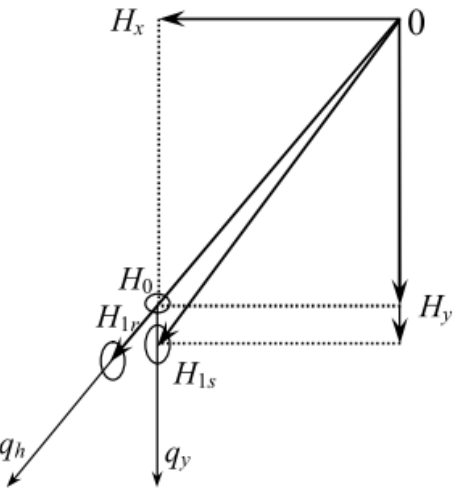
Figure 2. The reciprocal lattice sites of the GGG substrate (H 0 ) and the YIG film in the relaxed(H 1r ) and unrelaxed (H 1s ) states.